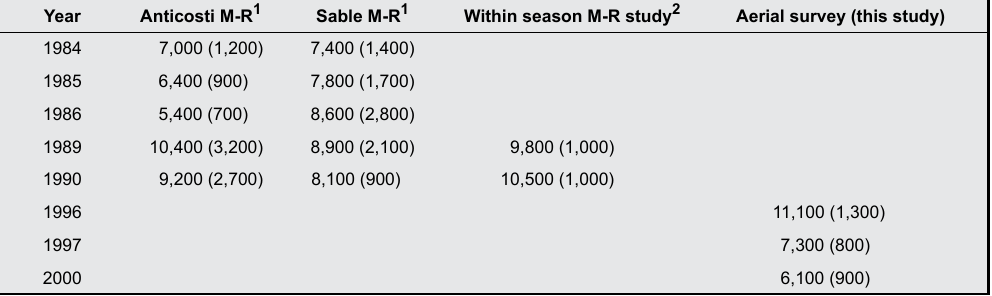
Table 8. Estimates of Non-Sable or Gulf grey seal pup production, from mark-recapture (M-R) and aerial surveys, rounded to the nearest 100. Standard errors are in